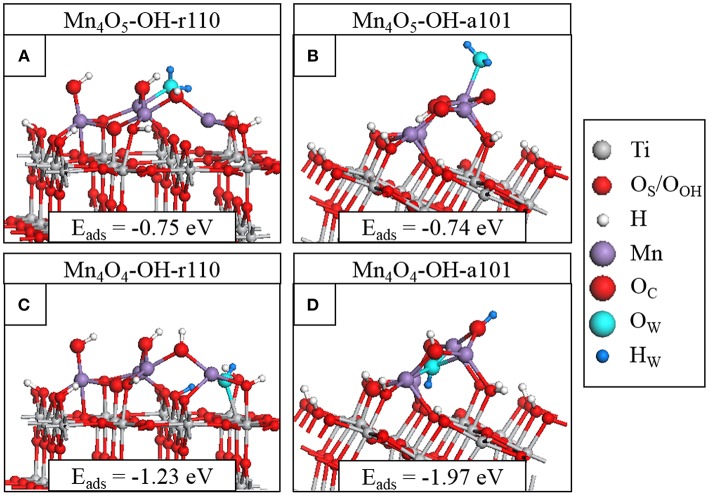
Relaxed atomic structures of the most stable configurations of H2O adsorbed at (A) Mn4O5-OH-r110, (B) Mn4O5-OH-a101, (C) Mn4O4-OH-r110, and (D) Mn4O4-OH-a101. Atomic species are distinguished by color according to the legend on the right hand side.